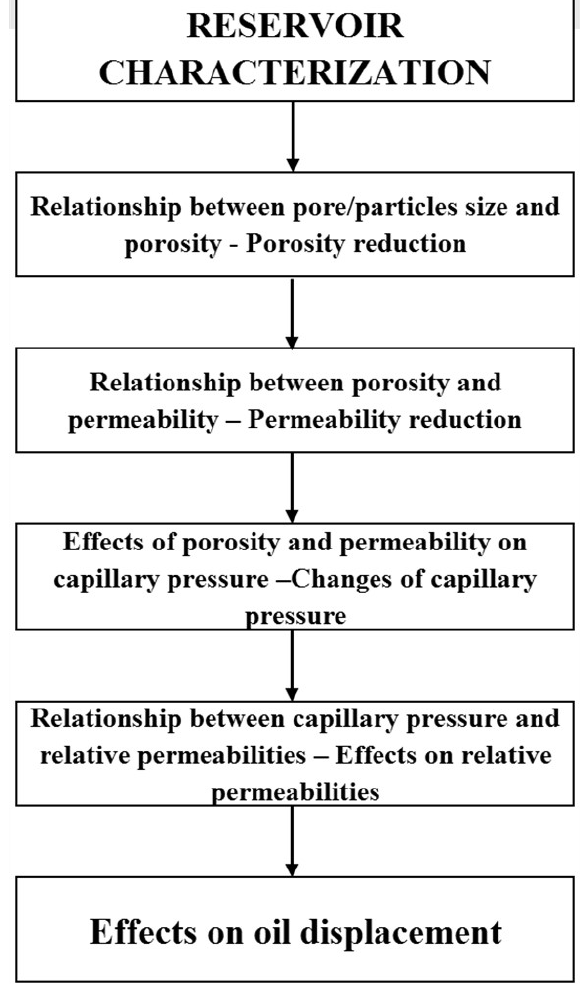
Figure 1. The simplified workflow of the model.